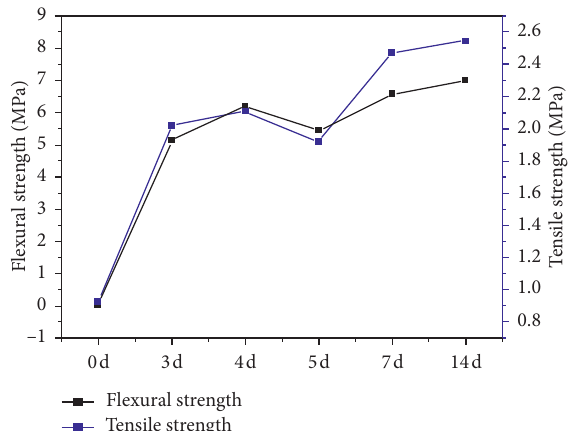
Figure 13: Tensile strength of SFP specimen and flexural strength of grouting material with different curing days.